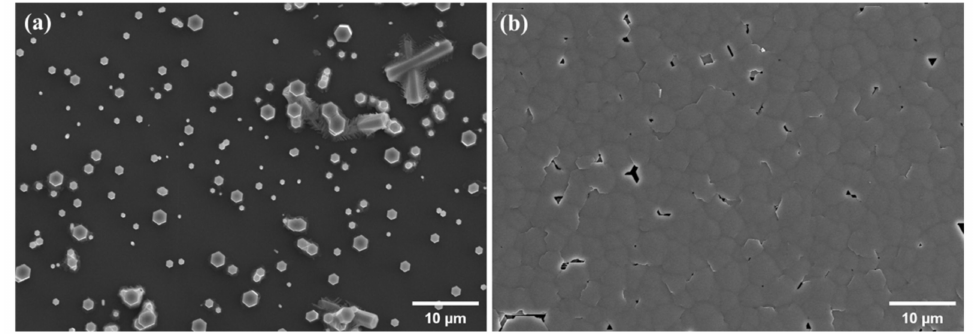
Figure 3. SEM images of ZnO micro-rods hydrothermally grown on 600 ◦ C annealed mica substrates from the solution containing ( a ) 0 mM and ( b ) 0.5 mM sodium